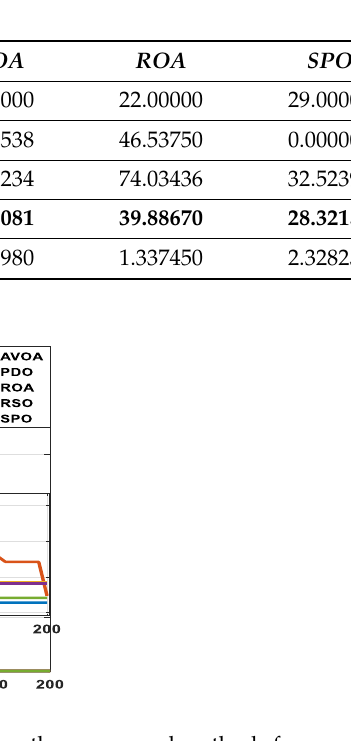
Figure 18. The AVOA convergence characteristics with the other compared methods for case 8.